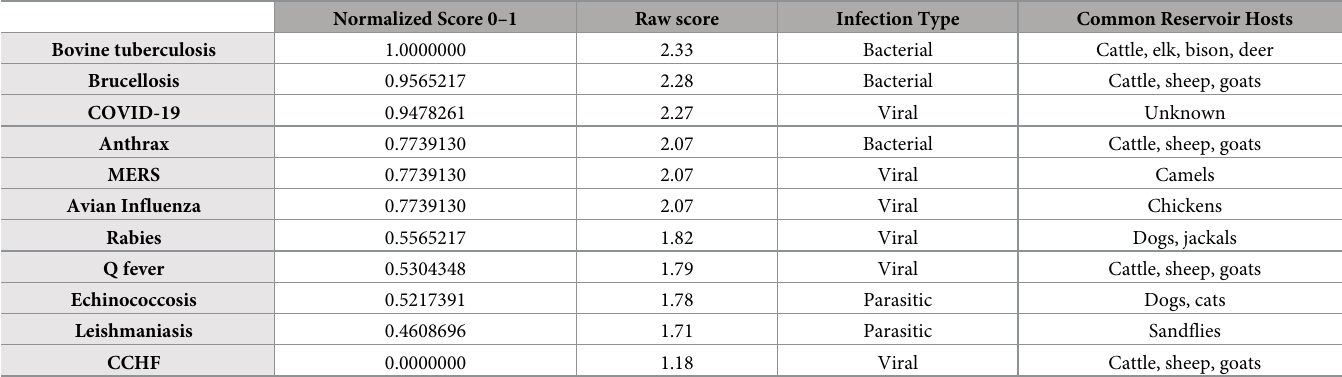
Table 6. Prioritized list of zoonoses within